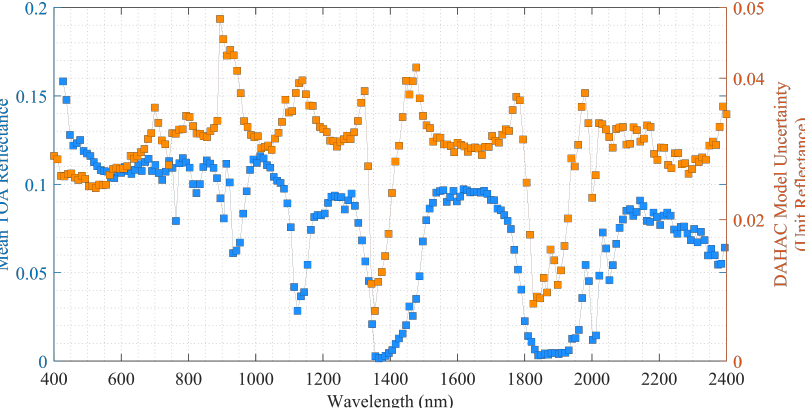
Figure 26. Mean TOA reflectance of the DAHAC model (blue colored) and DAHAC model’s uncer- tainty in unit reflectance (orange colored) for a 426–2395 nm wavelength